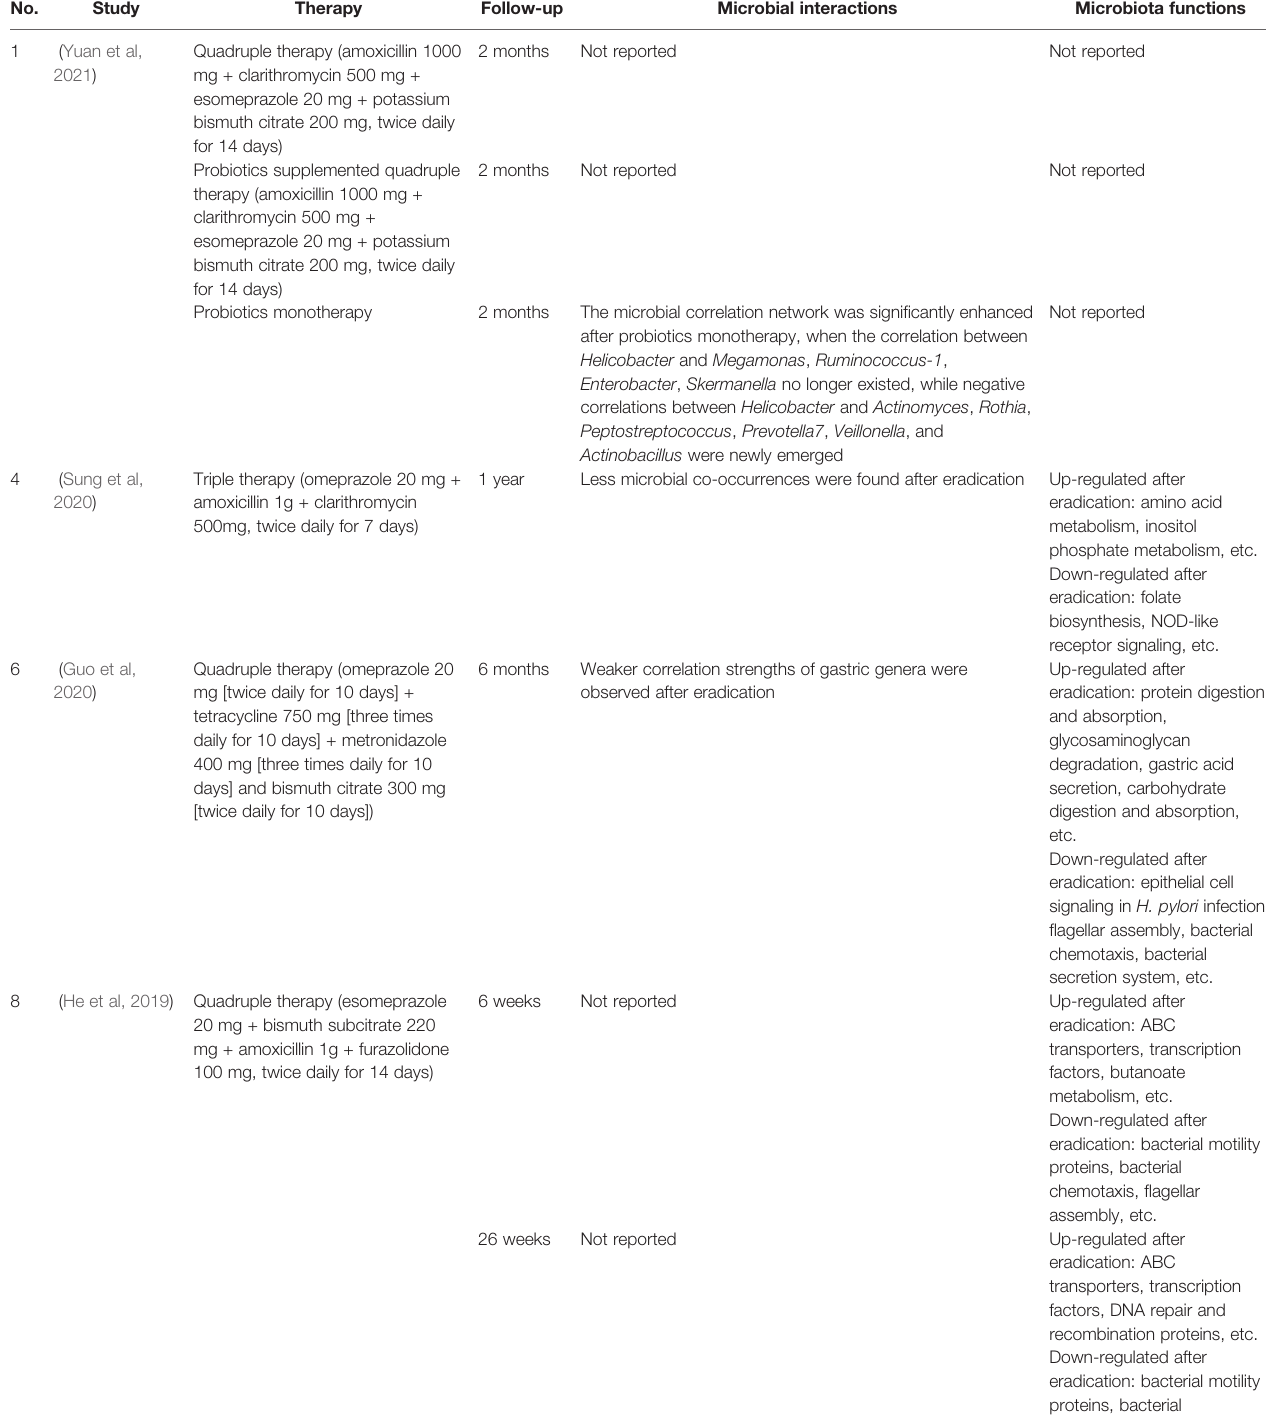
TABLE 4 | Major fi ndings of gastric microbial interactions and microbiota functions.